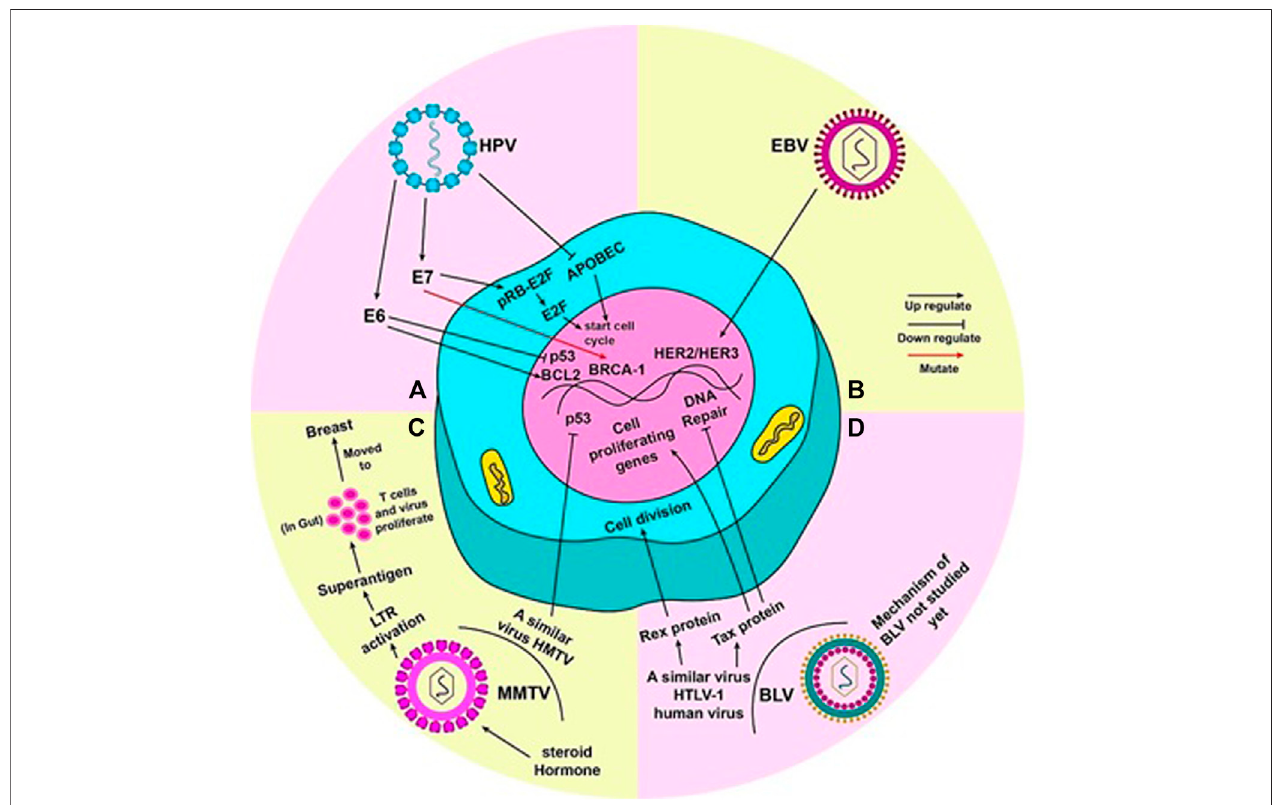
FIGURE2| Mechanismbywhicheachvirusissaidtocausebreastcancer: (A) Whenmutated,oncoproteins(E6andE7)ofHPVvirusactivatepro-tumorgenes.E6 activates BCL2 and inhibits p53, thus, promoting cell division. The pRB-E2f complex inhibits cell cycle; E7 detaches E2f from pRB and E2F alone commences the cell cycle. Mutation of BRCA-1 gene by E7 can also lead to tumor development. HPV also inhibits APOBEC (a cell cycle inhibitory molecule) to start cell cycle and cause genome instability. (B) EBV can activate HER2/HER3 gene(s) to render cell towards uncontrolled division. (C) Steroid hormones lead to ef fi cient replication and increasedexpressionofMMTVgenome.AnLTRintheMMTVgenomecodesforsuperantigenswhichactivateTlymphocytes.MMTVreplicatesrapidlyintheseTcellsin thegut, duringwhichitcanbecarried tothebreast.HMTV,avirussimilartoMMTV, caninhibit p53toinducetocellcycle. (D) ThetruemechanismbywhichBLVcauses cancer in humans has not been yet studied. However, HTLV-1, a virus similar to BLV present in humans, can lead to uncontrolled cell division by the production of Rex and Tax proteins. Tax protein accentuates this by activating cell proliferating genes and halting DNA repair mechanism of the cell.